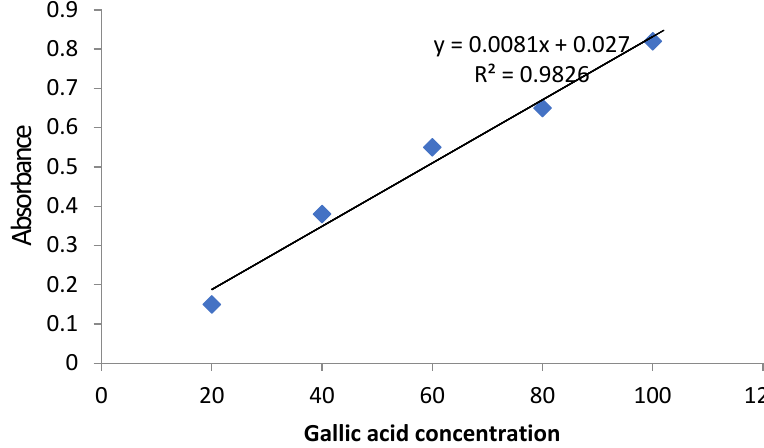
Figure 1. Gallic acid standard curve for determination of TPC.